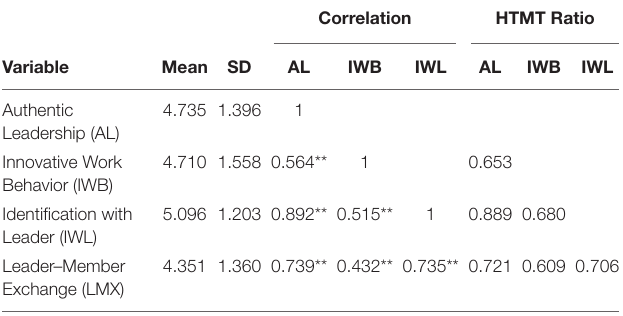
TABLE 3 | Descriptive statistics and hetero-trait mono-trait (HTMT) ratios.